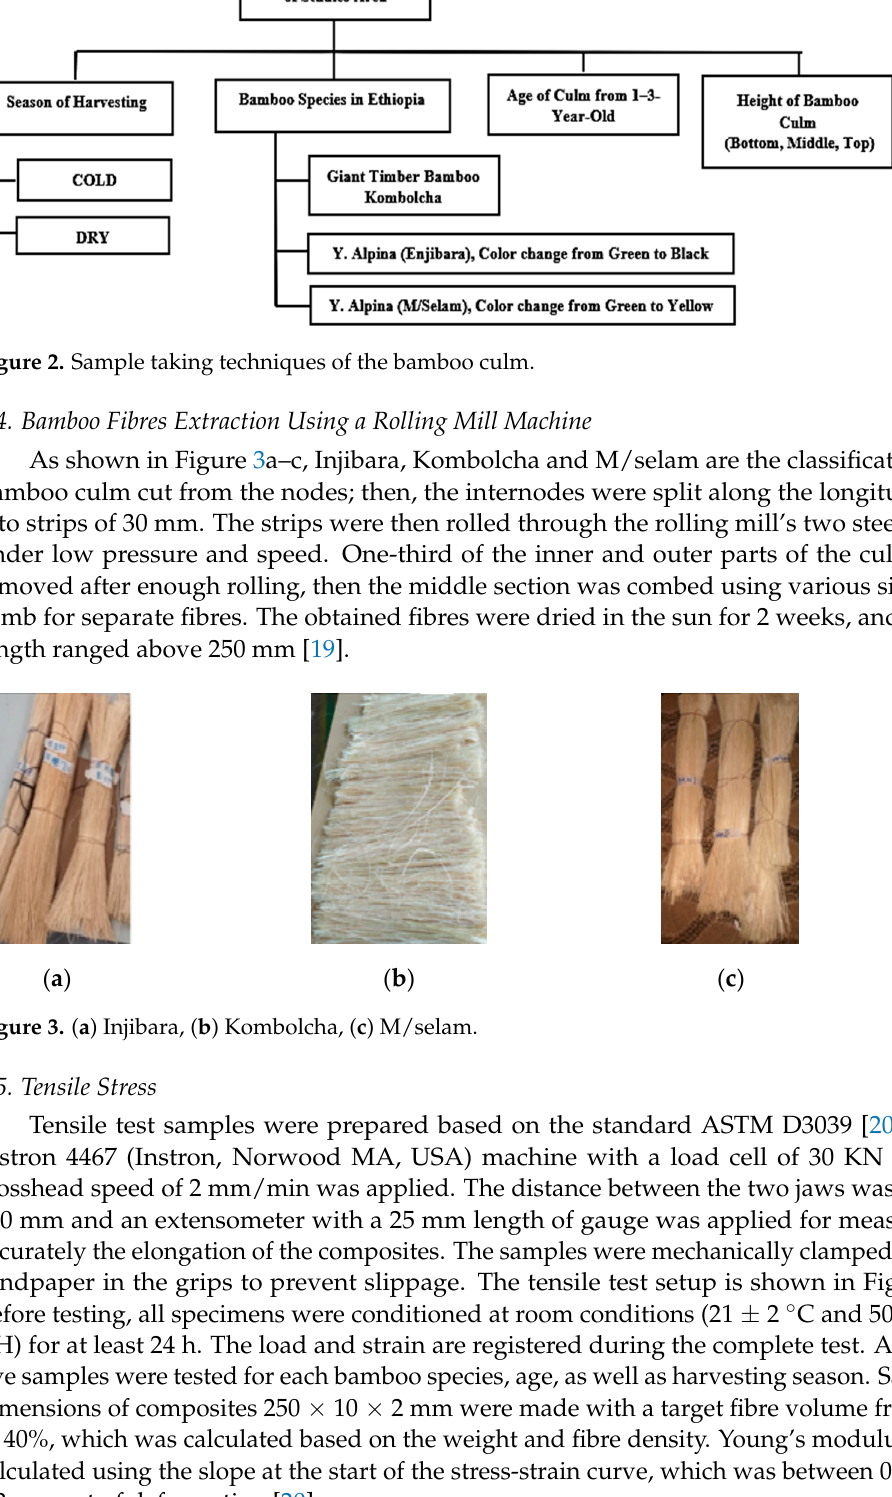
Figure 3. ( a ) Injibara, ( b ) Kombolcha, ( c ) M/selam.